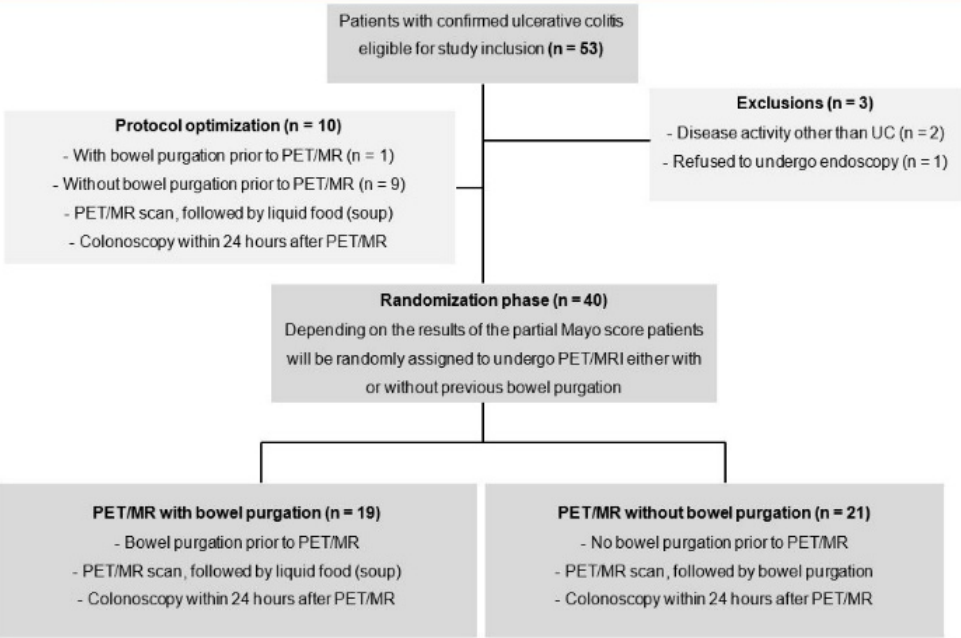
Figure 1. Study flowchart.